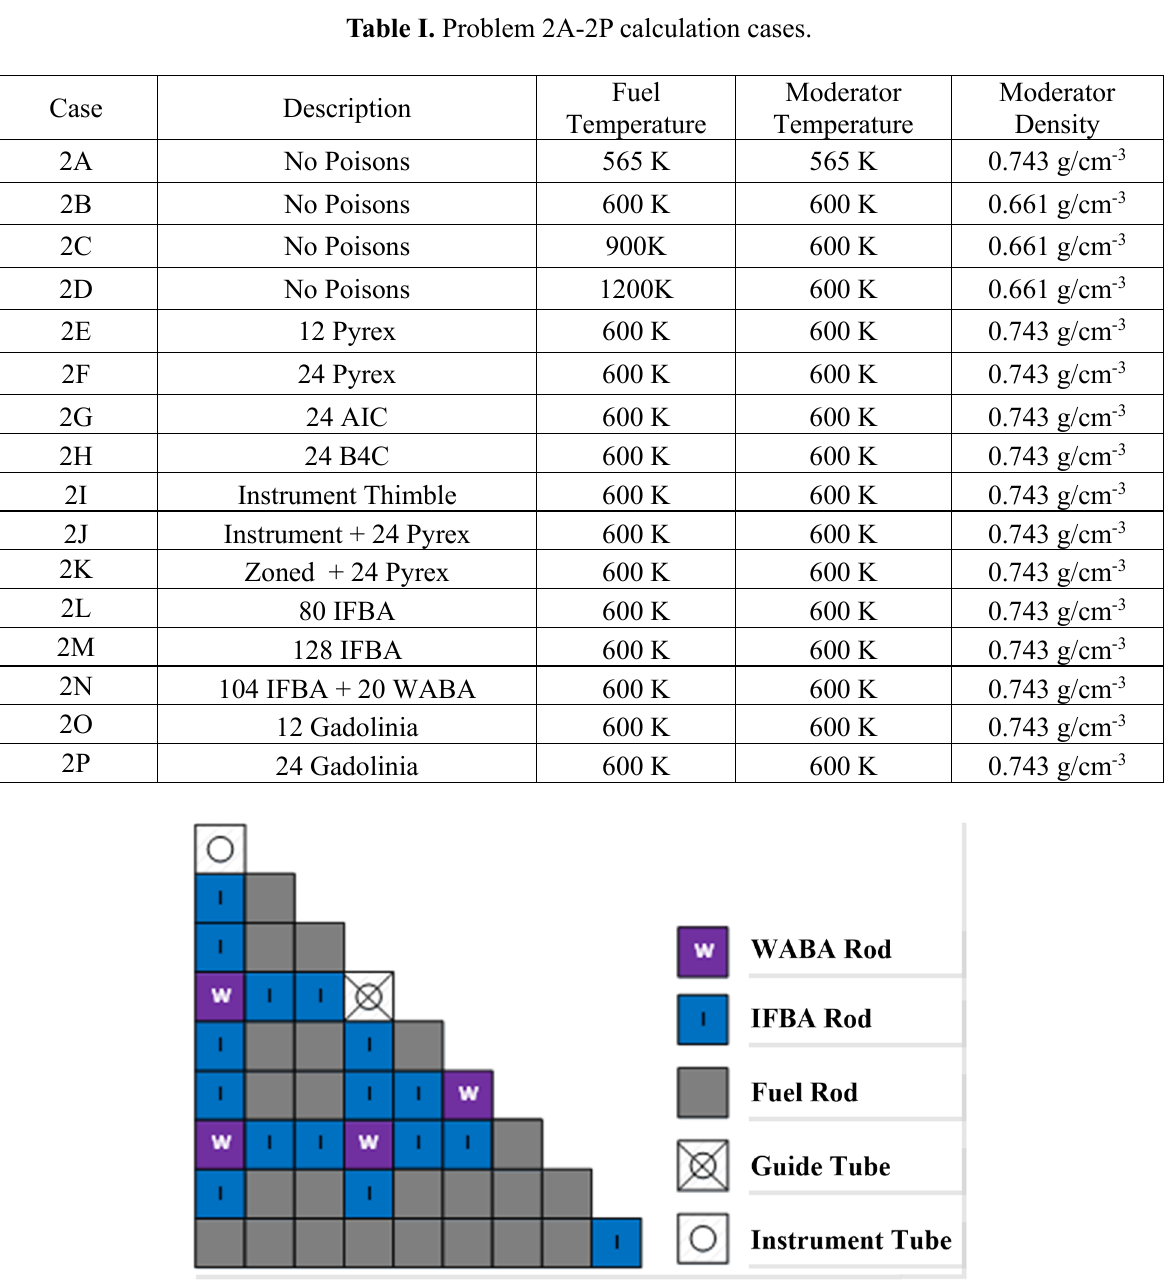
Figure 3. Problem 2N lattice layouts (Octant